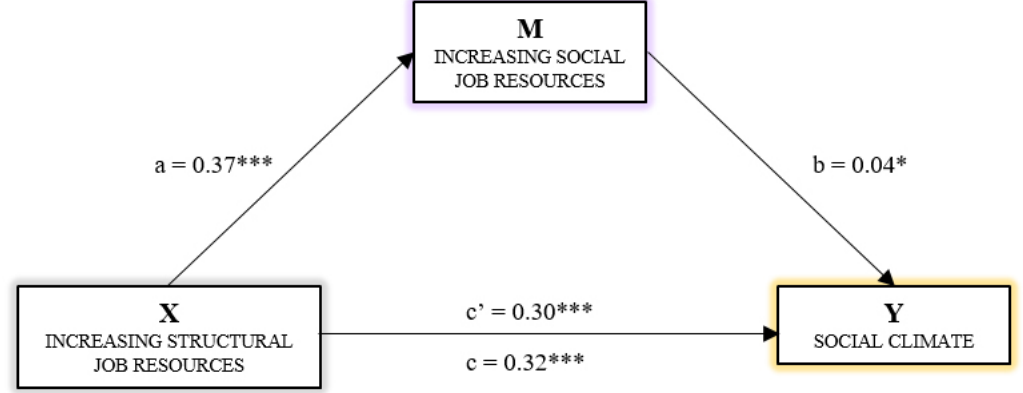
FIGURE 4. Simple mediation model for ISoJR on the relationship between the IStJR dimension of Job Crafting and Social climate of